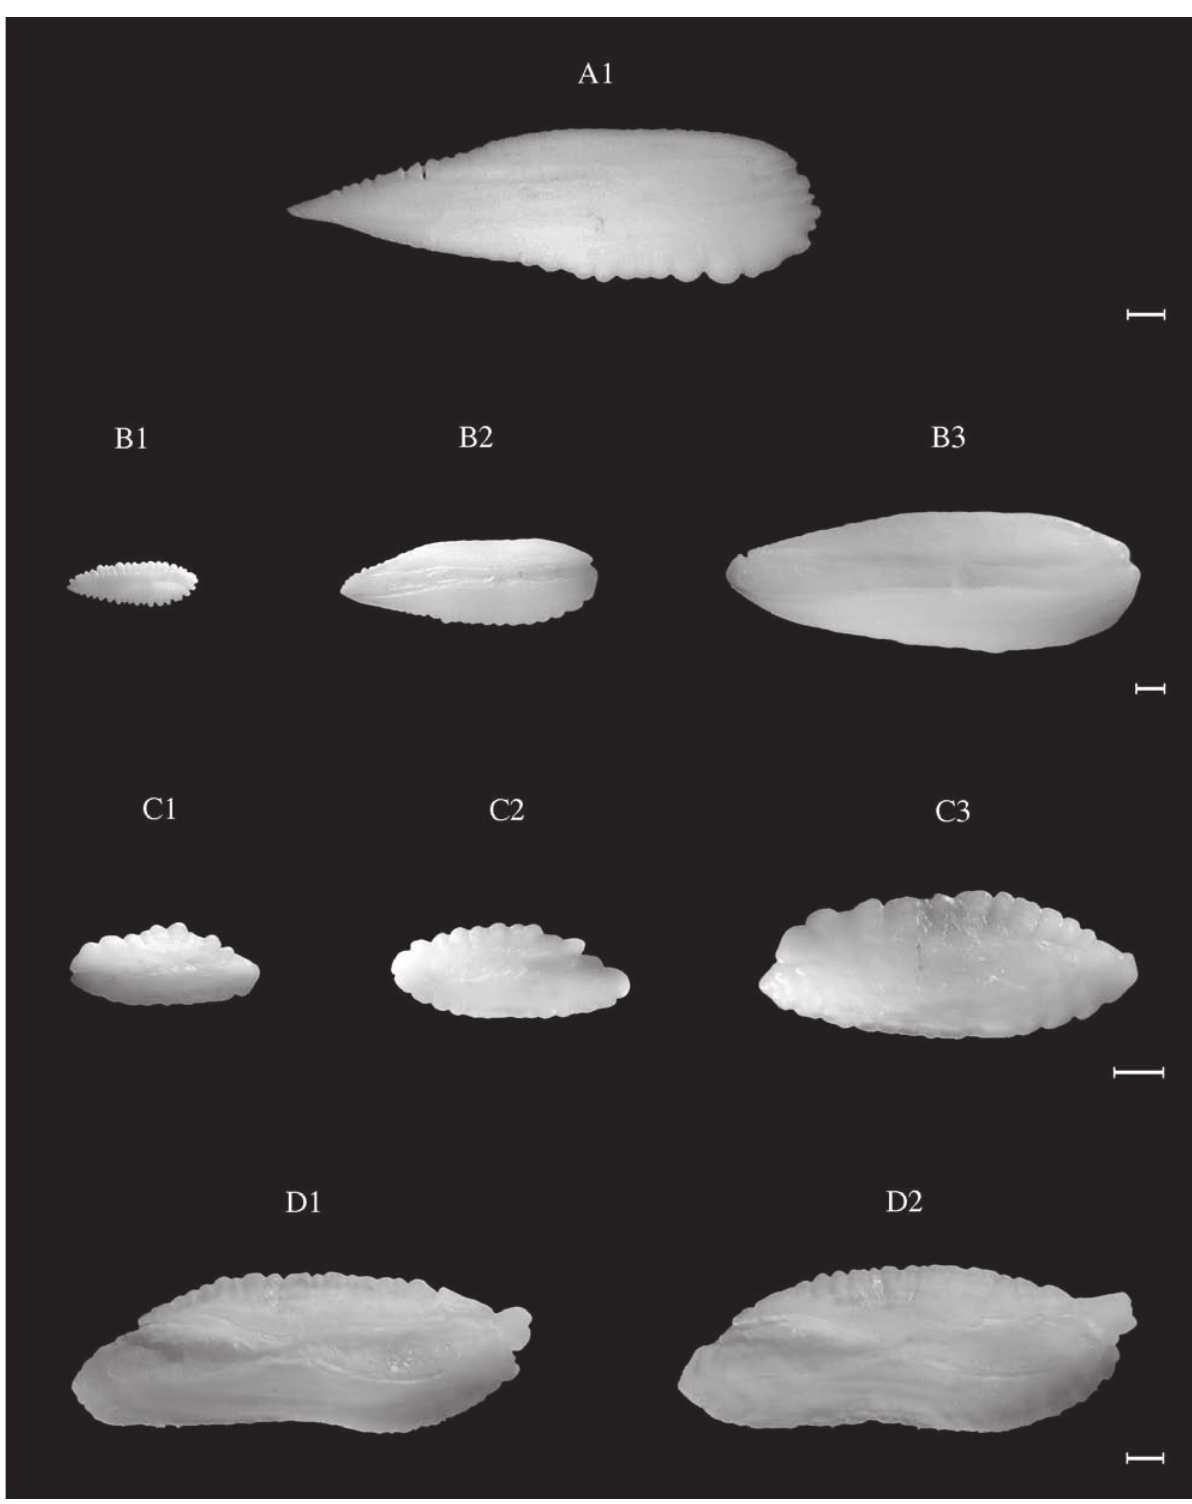
Fig. 31. – Merlangius merlangus (CEA). TL: A1, no data available. Micromesistius poutassou . TL: B1, 9.0 cm (WM); B2, 17.0 cm (WM); B3, 30.2 cm (NEA). Molva dypterygia (WM) . TL: C1, 18.0; C2, 24.0 cm; C3, 34.0 cm. Molva molva (NEA). TL: D1, 70.0 cm; D2, 73.7 cm. Scale bar = 1